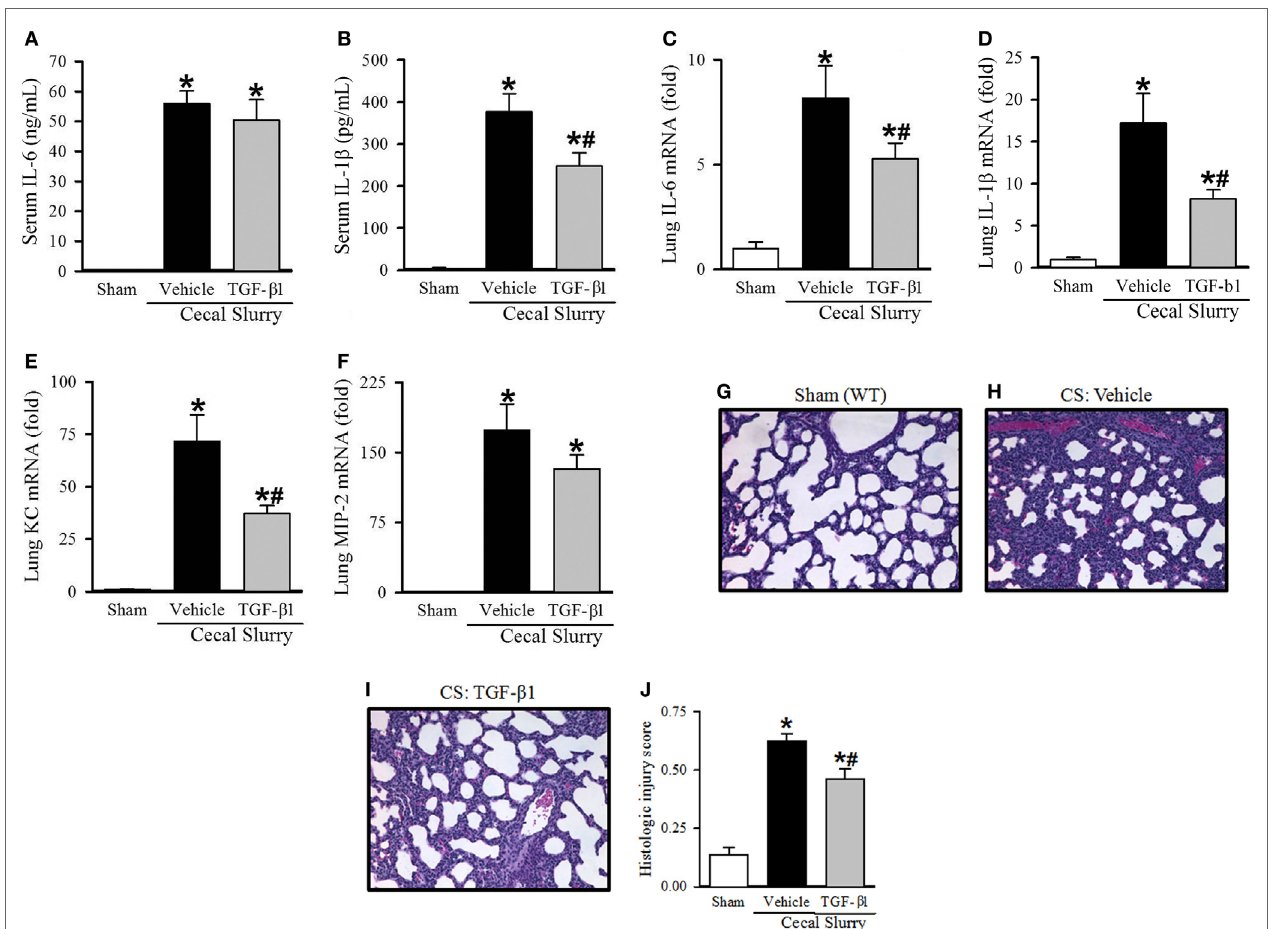
FigUre 6 | Effect of transforming growth factor (TGF)- β 1 administration inflammation and pulmonary injury in septic neonatal mice. Neonatal C57BL/6 pups received recombinant mouse TGF- β 1 (0.05 µg/g BW) or vehicle (PBS containing 0.8 mM HCl) intraperitoneal (i.p.) 1 h prior to sepsis induction. Sepsis was induced by i.p. injection of cecal slurry (0.9 mg/g BW); serum and lungs were harvested 10 h later. Serum levels of (a) IL-6 and (B) IL-1 β were measured by enzyme-linked immunosorbent assay. The mRNA levels of (c) IL-6, (D) IL-1 β , (e) keratinocyte chemoattractant, and (F) macrophage inflammatory protein-2 in the lungs were determined by qPCR. (g–i) Shown are representative hematoxylin and eosin-stained sections of the lung from (g) sham, (h) vehicle-, and (i) TGF- β 1-treated mice at 200 × magnification. (J) Histologic lung injury score was calculated for each group with a maximum possible score of 1. Data expressed as mean ± SEM ( n = 7–8 per group) and compared by one-way analysis of variance (* p < 0.05 vs. Sham, # p < 0.05 vs.